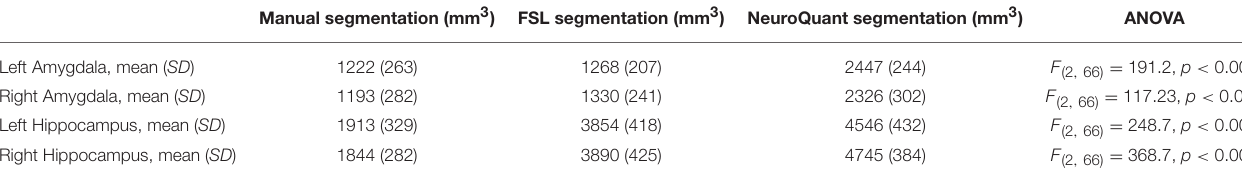
TABLE 1 | Means, standard deviations, and comparison of means between manual and automated segmentations.